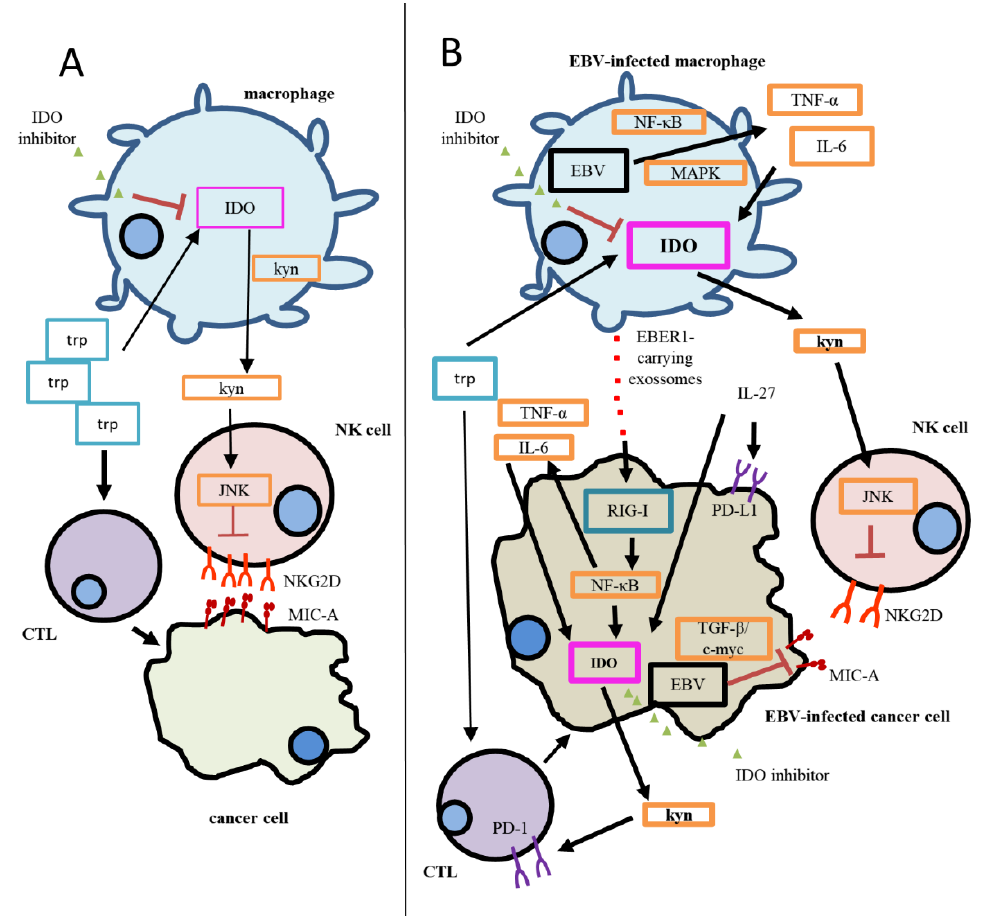
Figure 1. Proposed mechanism of the IDO-specific contribution to immunosuppression in EBV( − ) cancer and EBV(+) cancer. ( A ) During homeostasis, CTLs utilize tryptophan in order to eliminate cancer cells. The degradation of tryptophan generates Kyn, which negatively contributes to NKG2D regulation of expression in NK cells. ( B ) EBV has been reported to increase IDO expression in infected cells; therefore, Trp degradation is enhanced, and so is Kyn accumulation. As a result, a more significant immunosuppression status is established, since CTL responses are inhibited, and stronger inhibition of NKG2D in NK cells can be observed. In addition, MIC-A, a NKG2D ligand, has been reported to be downregulated in EBV-infected cancer cells through the TGF- β /c-myc pathway. In this model, the activation of the RIG-I pathway through EBER1, delivered by exosomes, directly regulates IDO expression in cancer cells and/or also activates the NF-kB pathway in them, inducing the production of TNF- α and IL-6, culminating in the upregulation of IDO. The increased IDO expression in cancer cells would exacerbate the immunosuppression by increasing Trp utilization and Kyn accumulation. IL-27 would also play a role in this scenario, contributing to the expression of both IDO and PD-L1; the latter IC receptor expression, PD-1, increases on CD8 + T cells as Kyn accumulates in the microenvironment. The use of specific IDO inhibitors would have a greater impact on EBV-associated malignancies, since IDO expression is higher when compared to EBV( − ) cases. Thick lines represent stronger activation/expression than thin lines (weaker activation/expression). EBV: Epstein–Barr virus; CTL: cytotoxic T cell; JAK3/STAT3: Janus-kinase-3/signal transducer and activator of transcription-3; KYN: kynurenine;